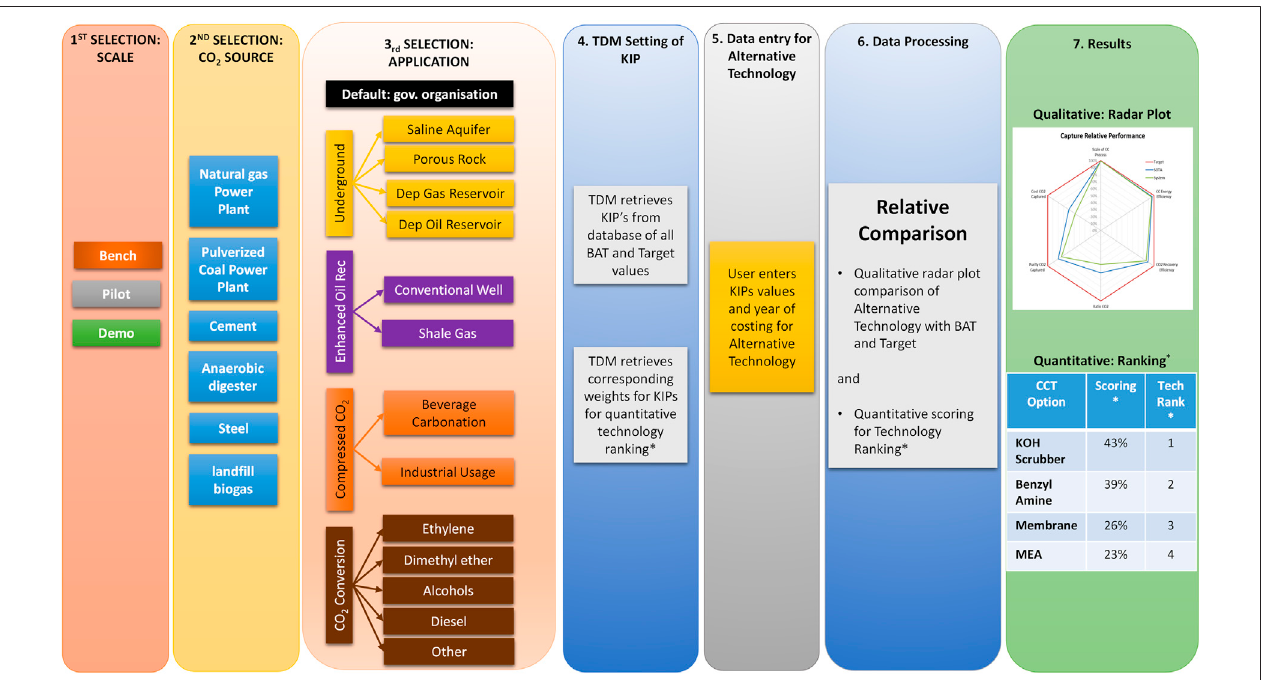
FIGURE 2 | Structure and overall approach of TDM tool. Note: items marked with * in columns 4, 6, and 7 are enhancements in the next generation of our TDM study.